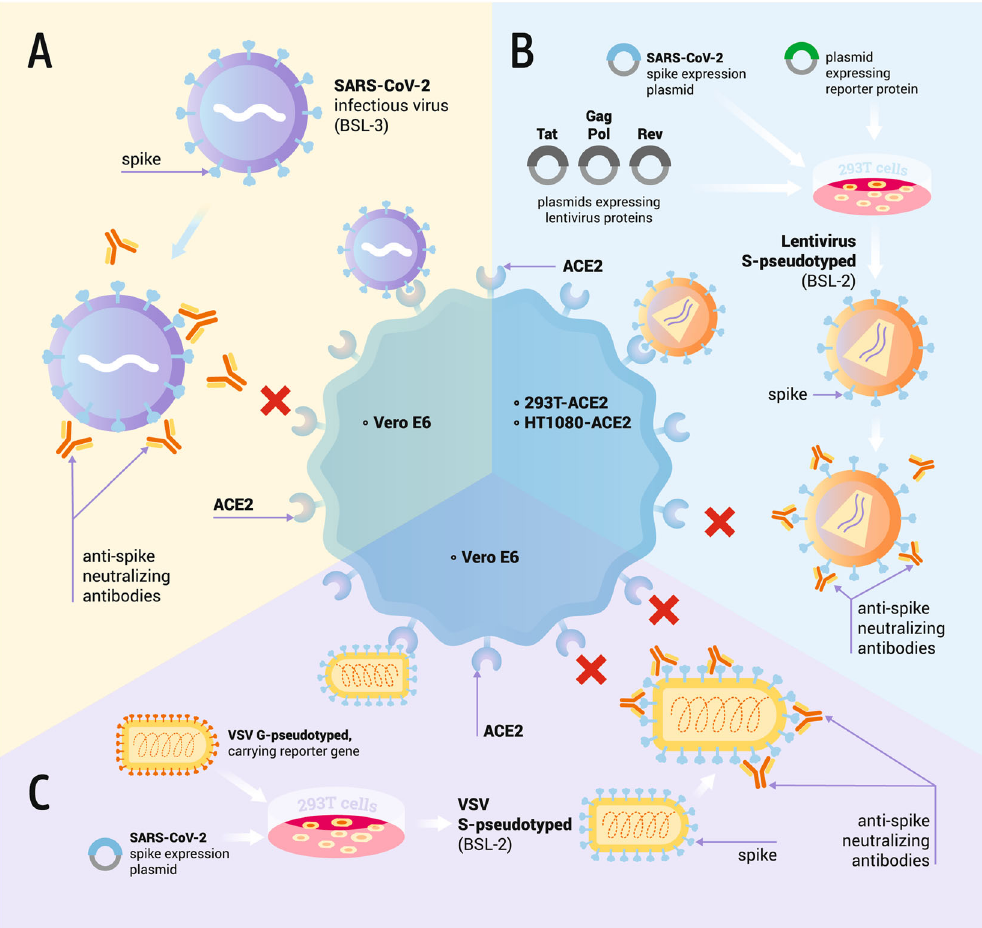
Fig. 2 Examples of the approaches used for testing antibody-mediated SARS-CoV-2 neutralization. A Cell culture-ampli fi ed SARS-CoV-2 infects cells expressing ACE2 receptor, e.g., Vero E6. When incubated with sera, neutralizing antibodies bind to the virus surface and block the interaction between virus spike (S) protein and ACE2 receptor, inhibiting virus entry. B 293T cells are transfected with plasmids coding for lentiviral structural and non-structural proteins, and SARS-CoV-2 spike and reporter protein. The produced spike-pseudotyped lentivirus vector enters ACE2-overexpressing cells (e.g., 293-ACE2 or HT1080-ACE2). Spike-ACE2 interaction can be blocked by neutralizing antibodies binding the SARS-CoV-2 spike. Reporter protein expression allows for the measurement of infection rate. C 293T cells are transfected with plasmid coding for SARS-CoV-2 spike, followed by infection with G-pseudotyped VSV carrying a reporter gene in the locus of the G-protein sequence. Cells produce spike-pseudotyped VSV particles that can enter cells expressing ACE2, e.g., Vero E6. Pseudovirus with the G gene deleted is only able to carry out a single round of infection. Cell entry can be inhibited by spike-binding SARS-CoV-2 neutralizing antibodies. Reporter protein expression allows for the measurement of infection